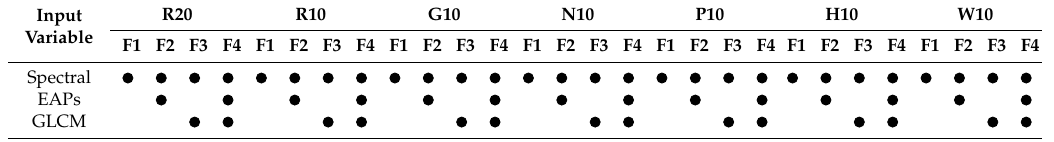
Table 3. The combination schemes of each data and feature sets of all twenty eight classification